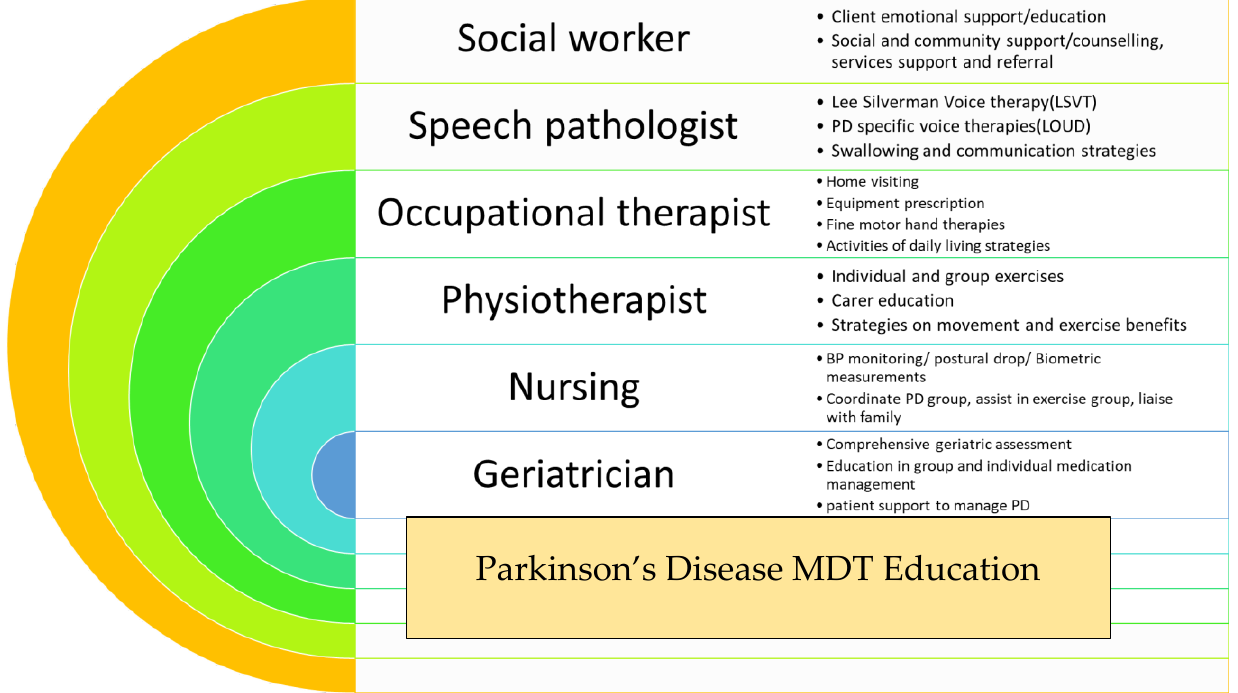
Figure 1. Summary of Parkinson’s disease (PD) programme at Rankin Park Centre Day Hospital, John Hunter Hospital, Newcastle, NSW, Australia.